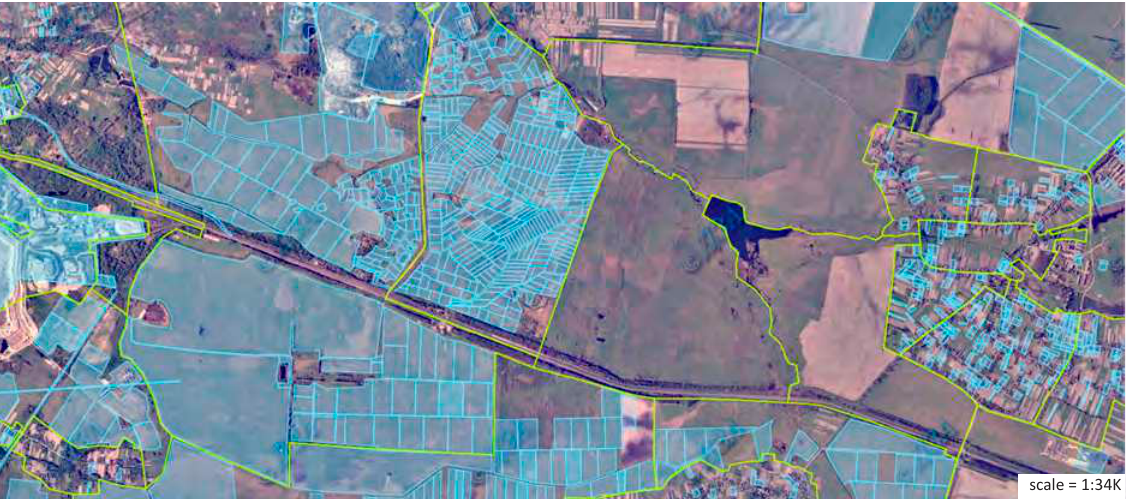
Figure 1. Cadastral map of key plot 1